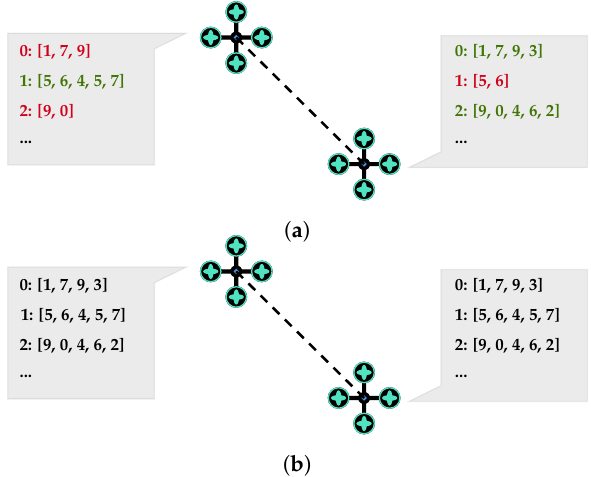
Figure 3. Every UAV stores the known path of each UAV. When two UAVs can communicate, they compare their known paths ( a ) and update them according to their length ( b ). ( a ) Each UAV’s known path is compared to the one from the coming information. It is red if the length is smaller than the one from the coming information and green otherwise. ( b ) Each UAV’s known path is updated according to the path with the biggest length among both information.